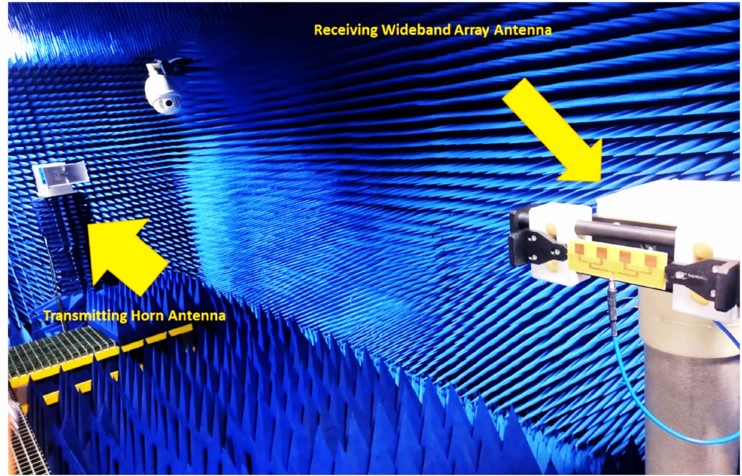
Figure 12. Radiation pattern and gain measurement setup of the